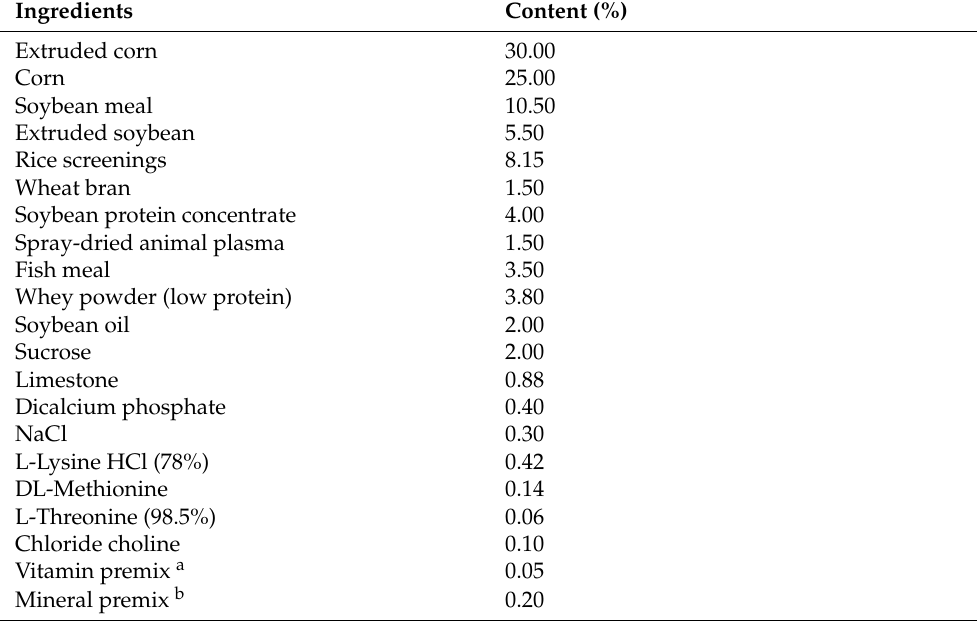
Table 1. Composition and calculated nutrient content of the basal